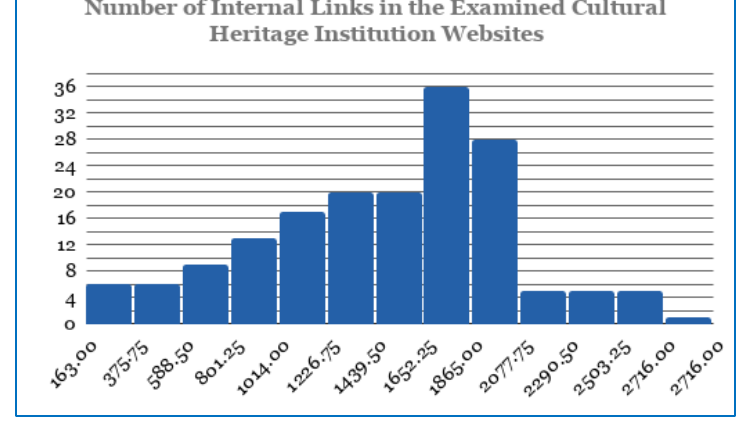
Figure 3. Histogram that explains the number of internal links included in the examined cultural heritage websites. Of the total, 36 websites ranged from 1652 up to 1865 internal links that allow users to navigate from one webpage to another with the purpose to provide cultural heritage content.